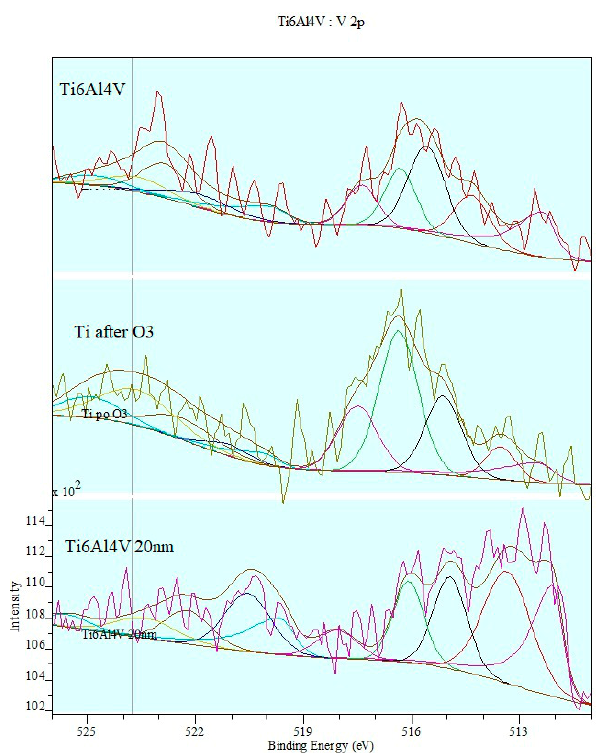
Figure 8. Effect of ozone treatment on XPS spectrum on the basis of V2p transitions.